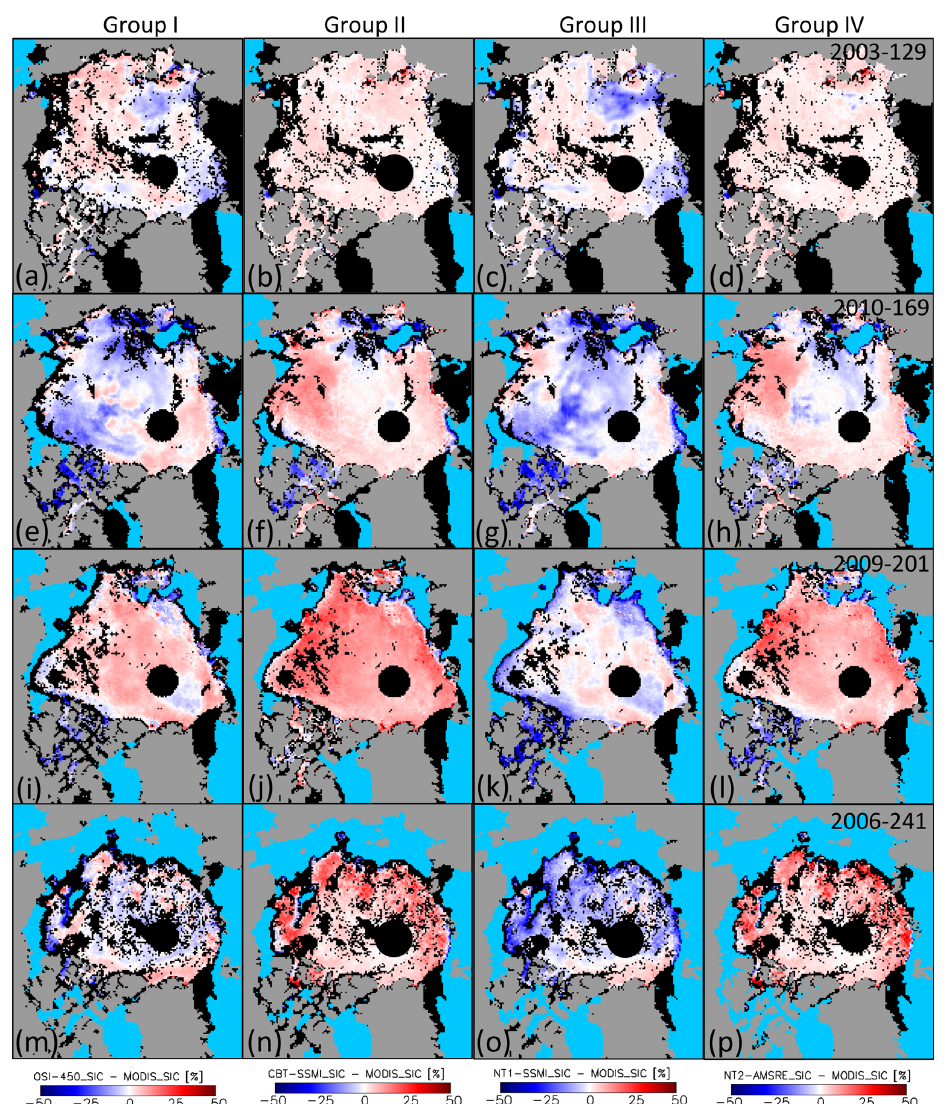
Figure 4. Maps of the difference of PMW minus MODIS sea-ice concentration for (a–d) : day of year (DOY) 129 (9–16 May) 2003, (e– h) DOY 169 (18–25 June) 2010, (i–l) DOY 201 (20–27 July) 2009, and (m–p) DOY 241 (29 August–5 September) 2006; these are the same periods as used in Fig. 2. The leftmost column shows OSI-450, representing group I; the second column CBT-SSMI, representing group II; the third column NT1-SSMI, representing group III; and the rightmost column NT2-AMSR-E, representing group IV. Black areas denote invalid or missing data, clouds, or grid cells that are ice covered but not considered further in the analysis, e.g. in the Greenland Sea or Hudson Bay. The row starting with (a) is representative of pre-melt, the row starting with (e) is melt advance, the row starting with (i) is at the peak of melt, and the row starting with (m) is at the end of